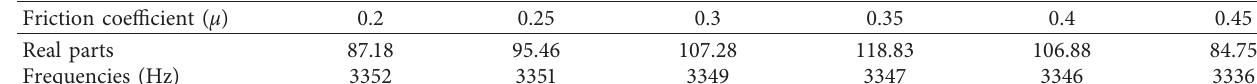
Table 5: Complex eigenvalue for different friction